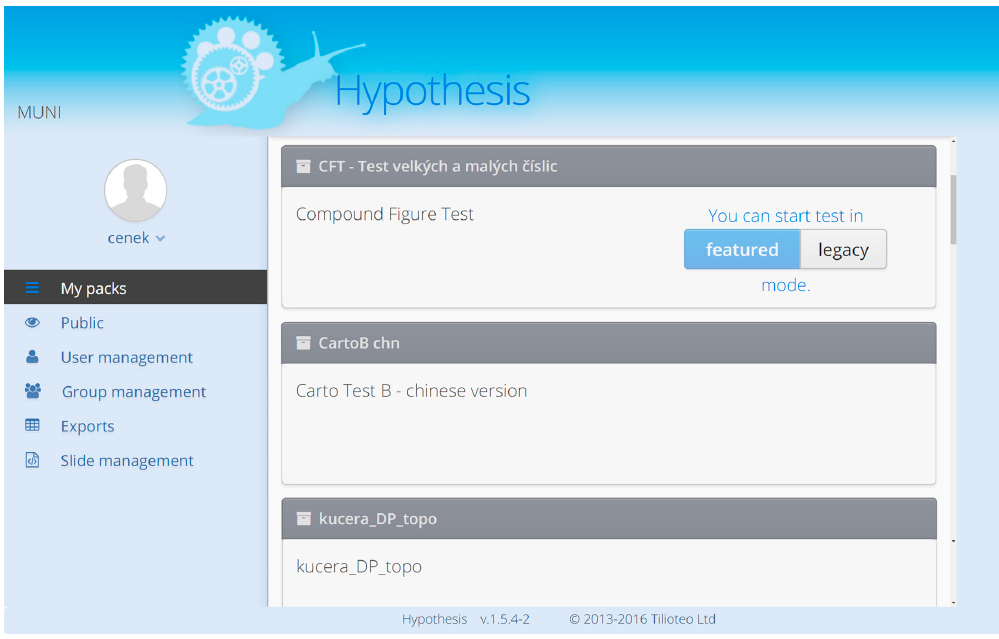
Figure 8. Opening of a Pack in a controlled (featured) or standard (legacy) mode.